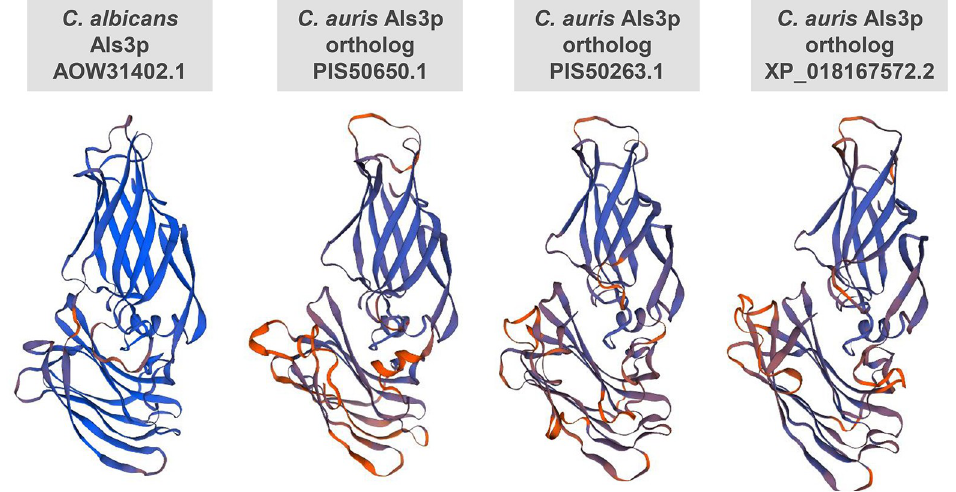
Fig 1. Similarity between 3-D structural models of C . albicans Als3p and C . auris Als3p homologs. Template were searched with BLAST and HHBlits was performed against the SWISS-MODEL template library (SMTL). Models were built based on the target-template alignment using ProMod3. Coordinates which was conserved between the target and the template were copied from the template to the model. Insertions and deletions were re-modelled using a fragment library. Side chains were then rebuilt. The geometry of the resulting model is regularized by using a force field. The models with high accuracy values were selected and are depicted for comparison.